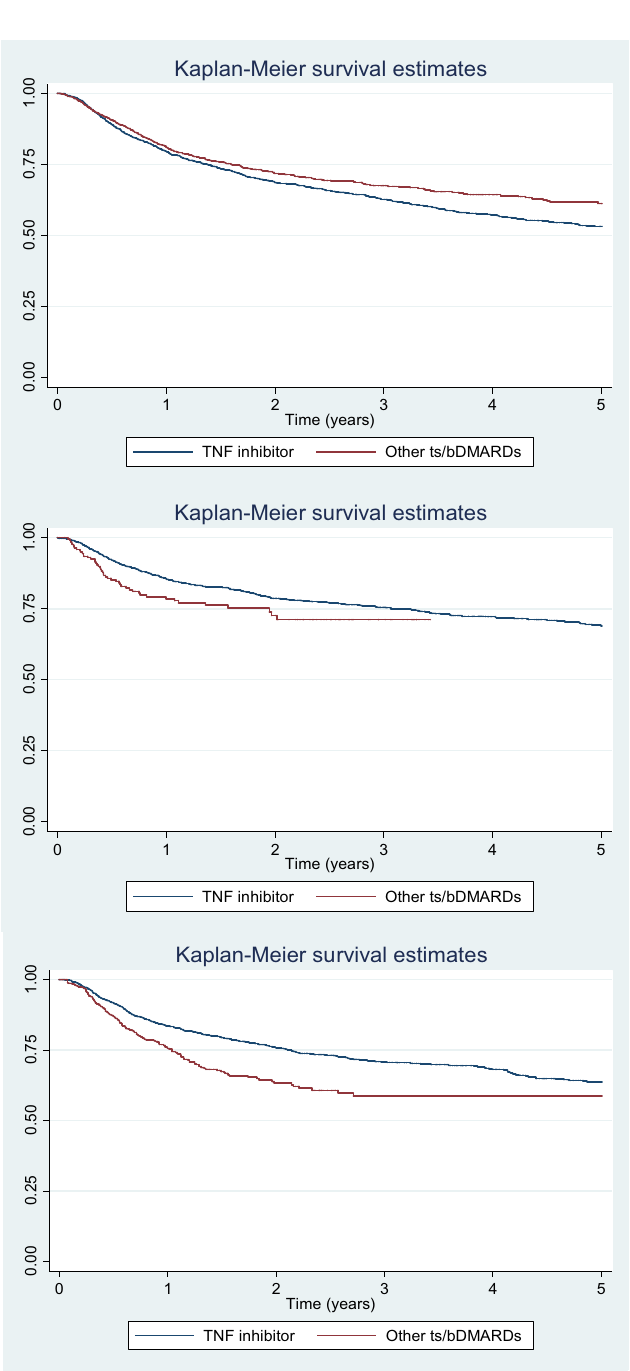
Figure 1. Kaplan–Meier survival curves for anti-TNFα vs. other ts/bDMARDs. ( a ) RA group (p = 0.01). ( b ) AS group (p = 0.02). ( c ) PsA group (p <